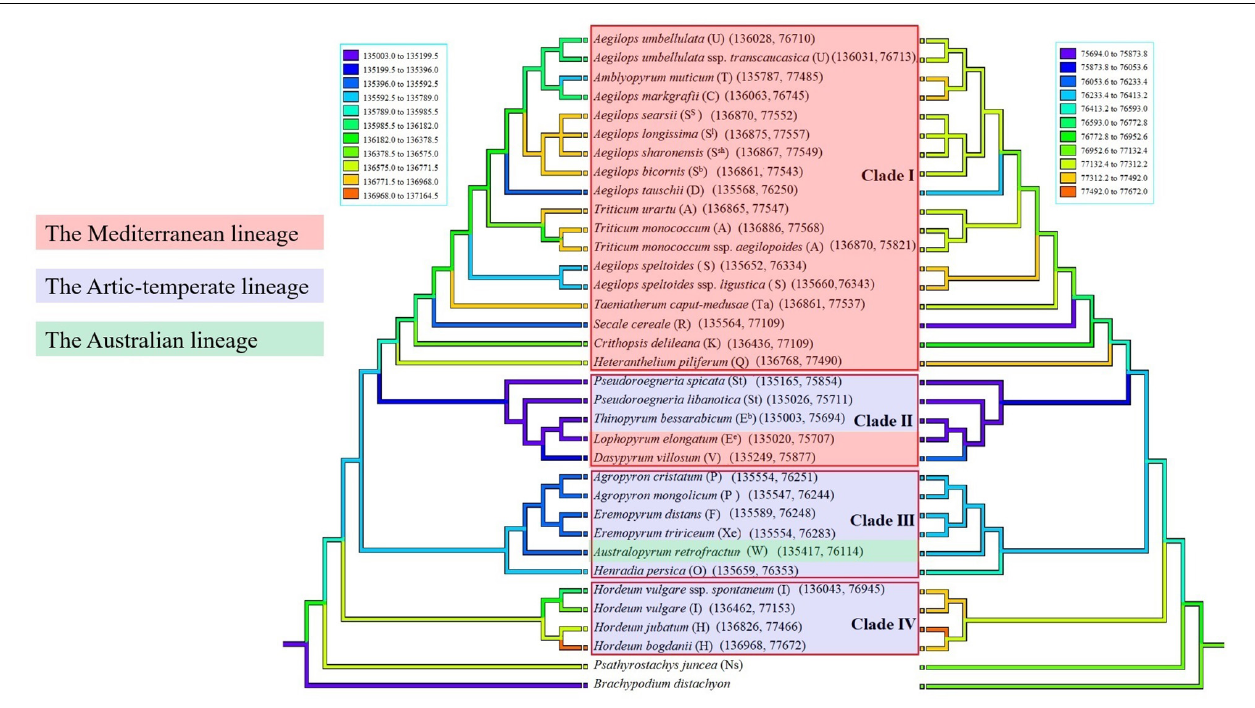
FIGURE 3 | Ancestral state reconstructions were traced on the ML tree inferred from two selected data (cp genome sequences and non-protein gene sequences) using weighted squared-change parsimony. Different colors labeled the geographic information of monogenomic genera. The capital letters in the bracket indicate the genome type of the